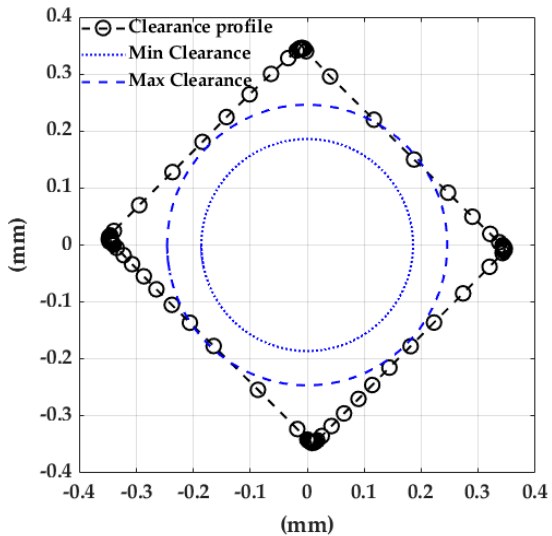
Figure 12. Flooded Ball & Socket Pivot bearing clearance profile from the bump test.